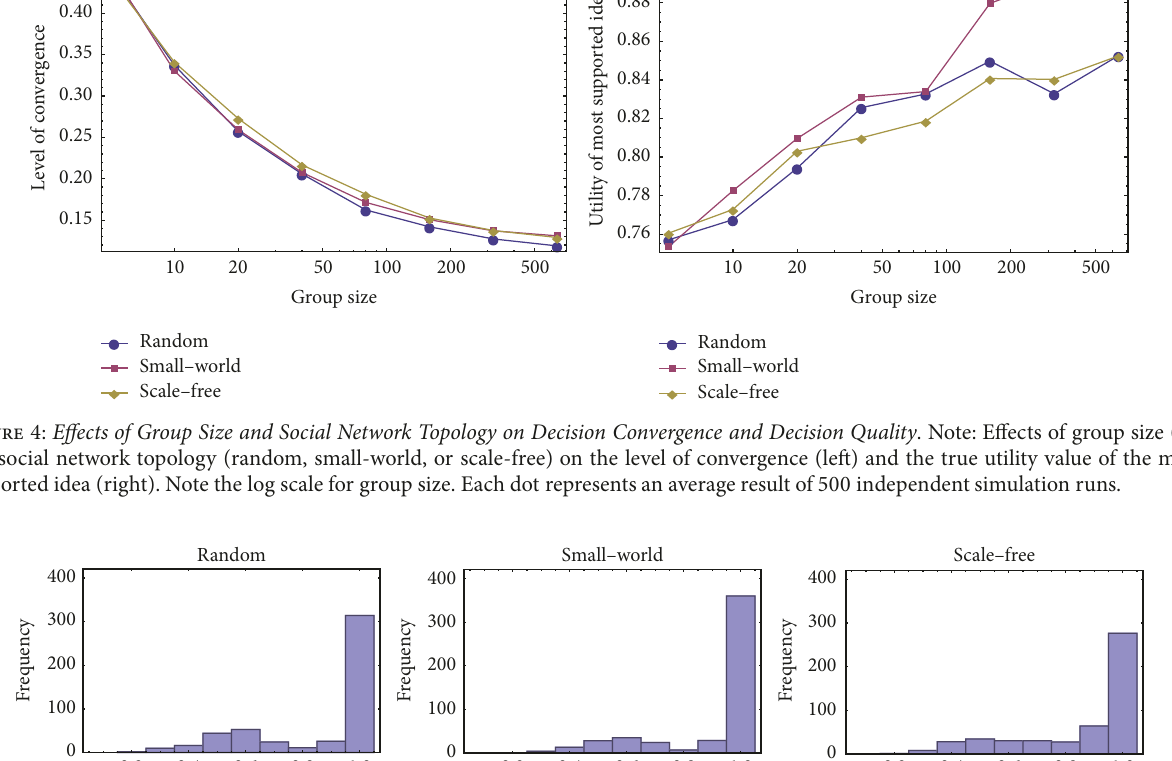
0.2 Figure 5: Distributions of Utilities of Most Supported Ideas between Different Social Network Topologies. Note: Simulation results comparing the distributions of utilities of most supported ideas at the end of simulation between the three social network topologies (random, small- world, or scale-free) for N = 640. The small-world network topology (middle) achieved the highest number of the maximal utility value (1.0) compared to the other two topologies, random (left) and scale-free